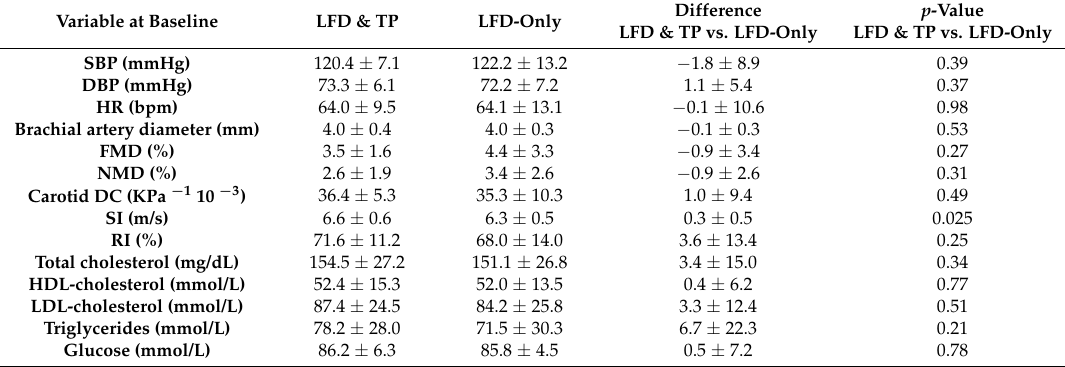
Table 1. Effects of 1 week of tomato paste on blood pressure (BP), vascular exams, and metabolic parameters in healthy young